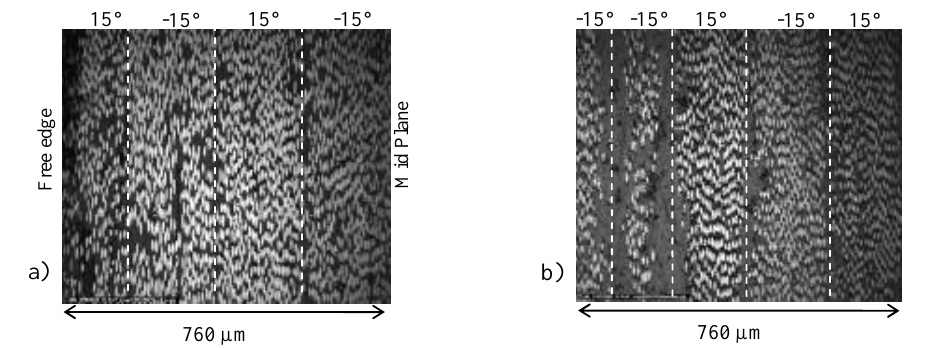
Fig. 1. Micrographic views of [(15/-15) 2 ] s laminates with “pure” (a) and “quasi” (b) UD microstructure